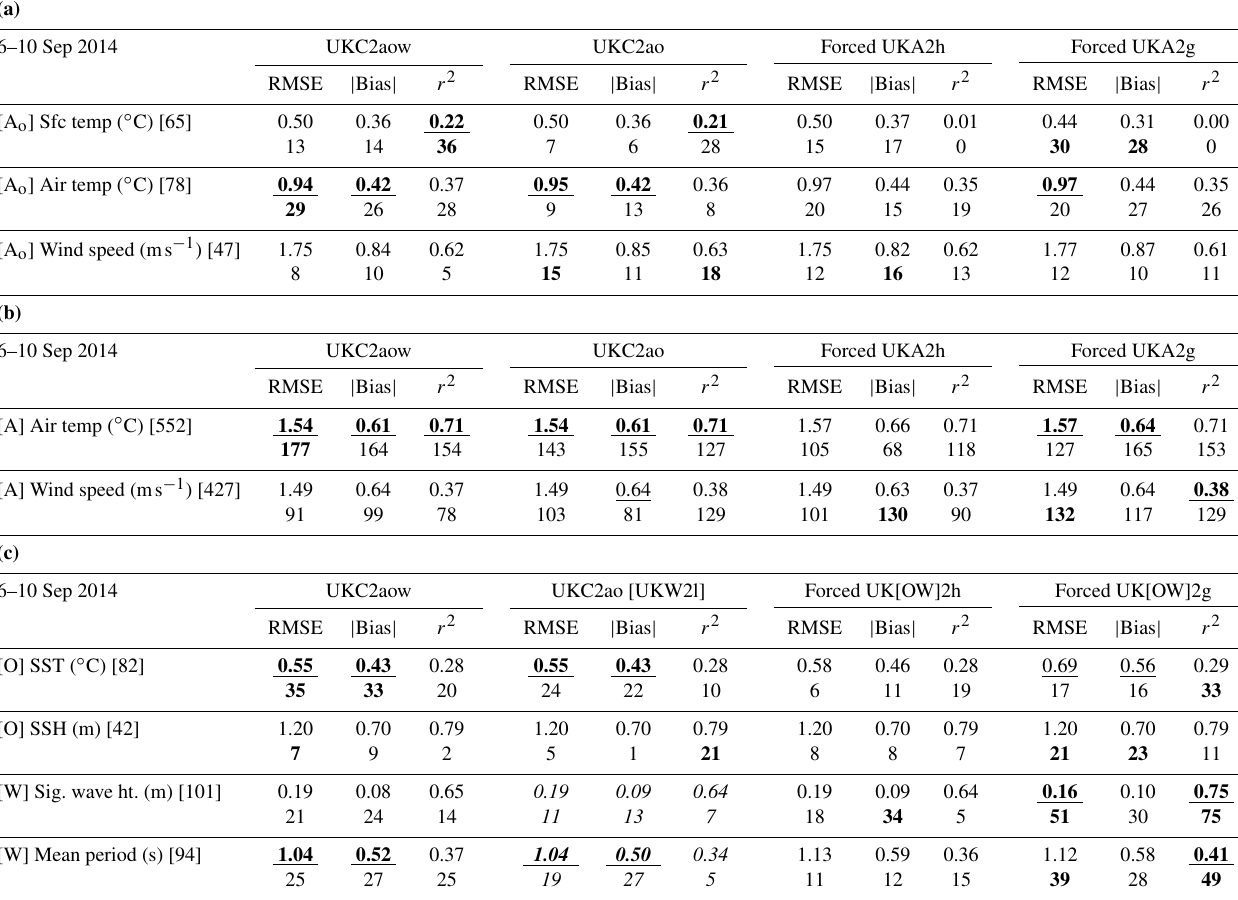
Table 5. Summary RMSE, bias and r 2 correlation coefficient statistics for the 6–10 September 2014 case study. Average statistics are computed from a comparison of model output against in situ observations of (a) atmosphere [A o ] model variables over sea grid cells only, (b) all atmosphere [A] model variables, and (c) ocean [O] and wave [W] model variables. The relevant forced configuration with high-resolution forcing UKW2h, UKO2h and UKA2h are treated as the reference control model. Results showing a statistically significant difference from the reference according to a t test at the 95% confidence level are underlined. Those also showing an improvement against the reference are also in bold. Also listed for each variable under the horizontal lines for each metric is the number of sites for which the model configuration provided the best statistic relative to the other model configurations tested for this case. The configuration with the highest number of sites listed is highlighted in bold. Numbers in square brackets show the number of observation locations assessed for each